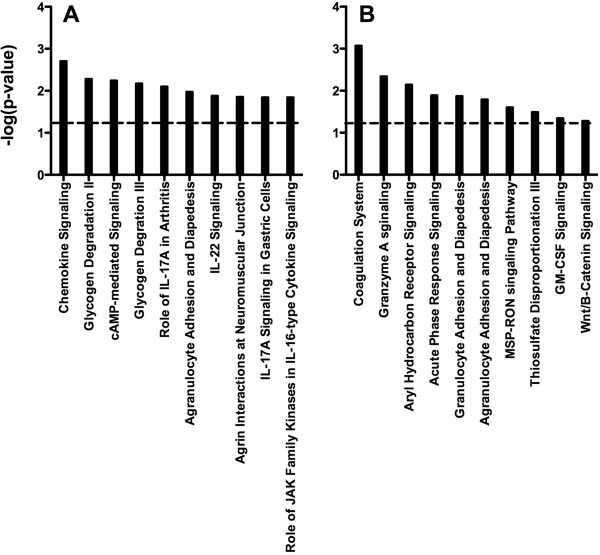
Canonical pathway analysis. CRPS affects transcriptional programs unique to each of the acute and chronic timepoints. All pathways were scored and ranked according to Ingenuity Pathway Analysis using Fisher’s exact test. The dotted line indicates the threshold value of p<0.05.